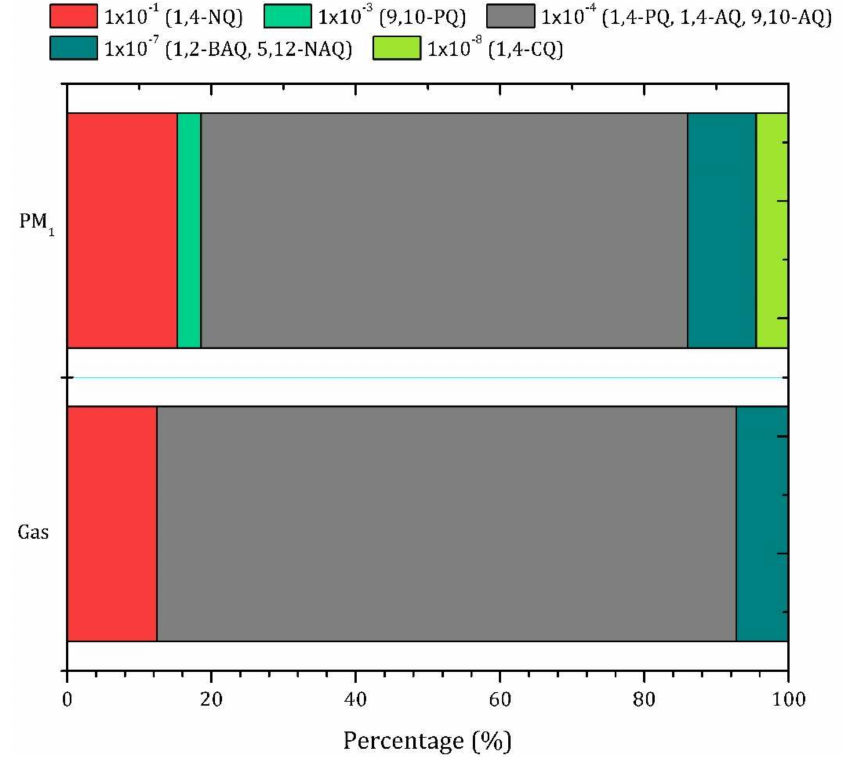
Figure 6. Distribution of quinones in the gas phase and PM 1 according to vapor pressure